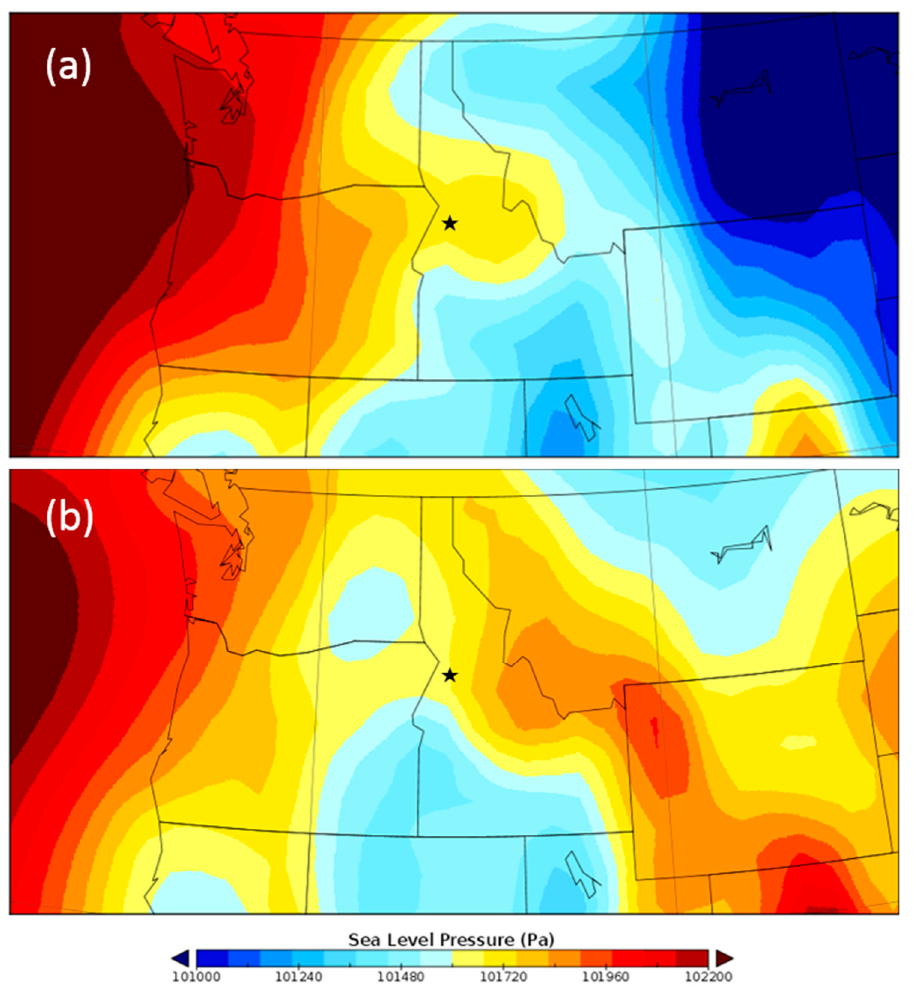
Figure 6. ERA-Interim sea level pressure analysis for 0600 LT on: ( a ) non-event day 18 August; and ( b ) event day 17 August. The study area is indicated with a star.